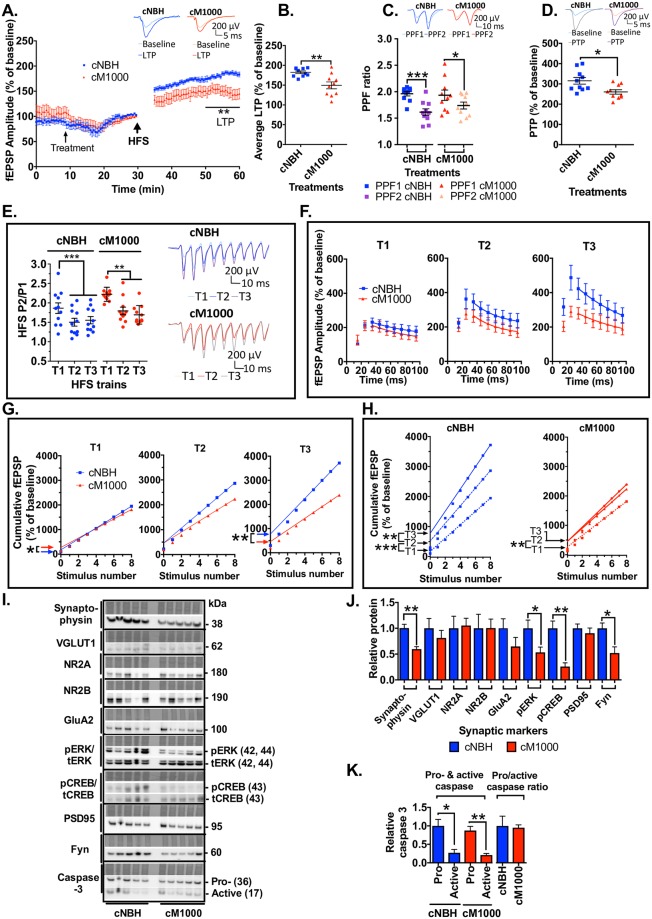
Acute PrPSc synaptotoxicity is largely PrPC independent.Hippocampal slices derived from PrPo/o mice were used for these experiments. (A) cM1000 superfused over slices approximately 20 minutes prior to HFS trains caused significant impairment of LTP with (B) average LTP reduced by ~37 ± 12% (n = 10) compared with cNBH. (p = 0.0046). (C) A normal Pr during LTP in slices exposed to both cNBH and cM1000, where PPF2 (after treatment and LTP) became significantly reduced compared with the PPF1 (before treatment and LTP) (p = 0.0003). (D) PTP was significantly disrupted after exposure of slices to cM1000 relative to cNBH (p = 0.0133). (E) A normal increase in the Pr during HFS trains despite treatment with cM1000, demonstrated by a significant increase in the P1 to P2 ratio in T2 and T3 relative to T1. (F) A normal depletion rate of RRP after cM1000 exposure relative to cNBH across the three HFS trains, wherein the time constant of decay (Tau = 1/K) between P3 and P9 in each HFS train was not different between slices treated with cNBH and cM1000. (G) The size of RRP (determined by the Y-intercepts) in slices treated with cM1000 were modestly but significantly increased in T1 relative to slices treated with cNBH (cNBH: 173 ± 16, cM1000: 269 ± 15; p = 0.0111), demonstrating distinctive mechanisms of the acute synaptotoxicity in PrPo/o hippocampi; however, the RRP size of slices treated with cM1000 became significantly reduced in T3 relative to cNBH. (H) The RRP refill in slices treated with cM1000 (estimated by the increase in RRP size between trains) was normal between T1 and T2 (significantly increased from 169 ± 15 in T1 to 450 ± 28 in T2; p = 0.0048), but failed to significantly increase between T2 (450 ± 28) and T3 (461 ± 29) (G), thereby reflecting a significantly reduced RRP size. (I & J) Western blotting of PrPo/o hippocampi treated with cM1000 revealed reduced level of synaptophysin (p = 0.0024), but not VGLUT1. Exposure to cM1000 significantly reduced hippocampal pERK (p = 0.0432) and pCREB (p = 0.0034) relative to hippocampi treated with cNBH. Expression levels of NR2A and NR2B-containing NMDAR, and GluA2-containing AMPAR were unaffected by cM1000 treatment. PSD95 and Fyn levels were unaltered by cM1000 (p = 0.0168). (I & K) Pro-caspase 3 and production of its active form were unaltered in PrPo/o hippocampi treated with cM1000 relative to cNBH. (I) Molecular weight markers are provided at right. (A, C, D, E) Examples of raw fEPSP traces are provided as insets. Data are presented as ± SEM. *p<0.05, **p<0.01, ***p<0.001, ****p<0.0001.